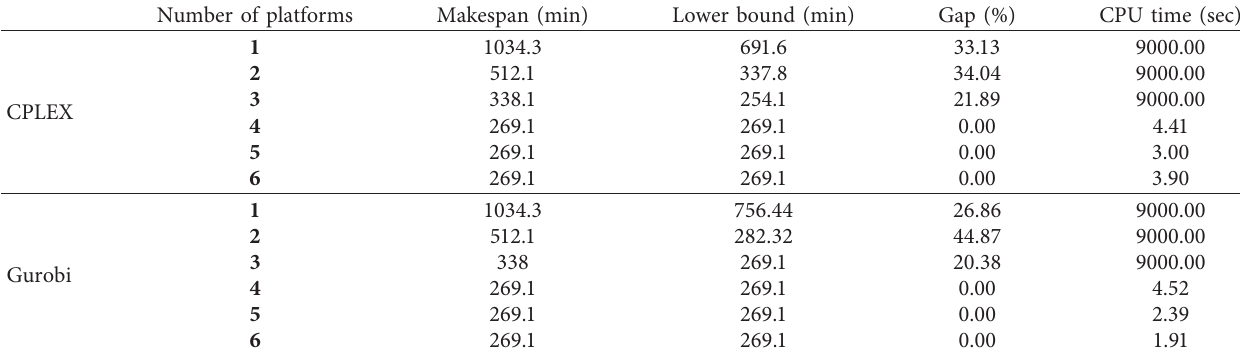
Table 1: Obtained results for the current B shift.